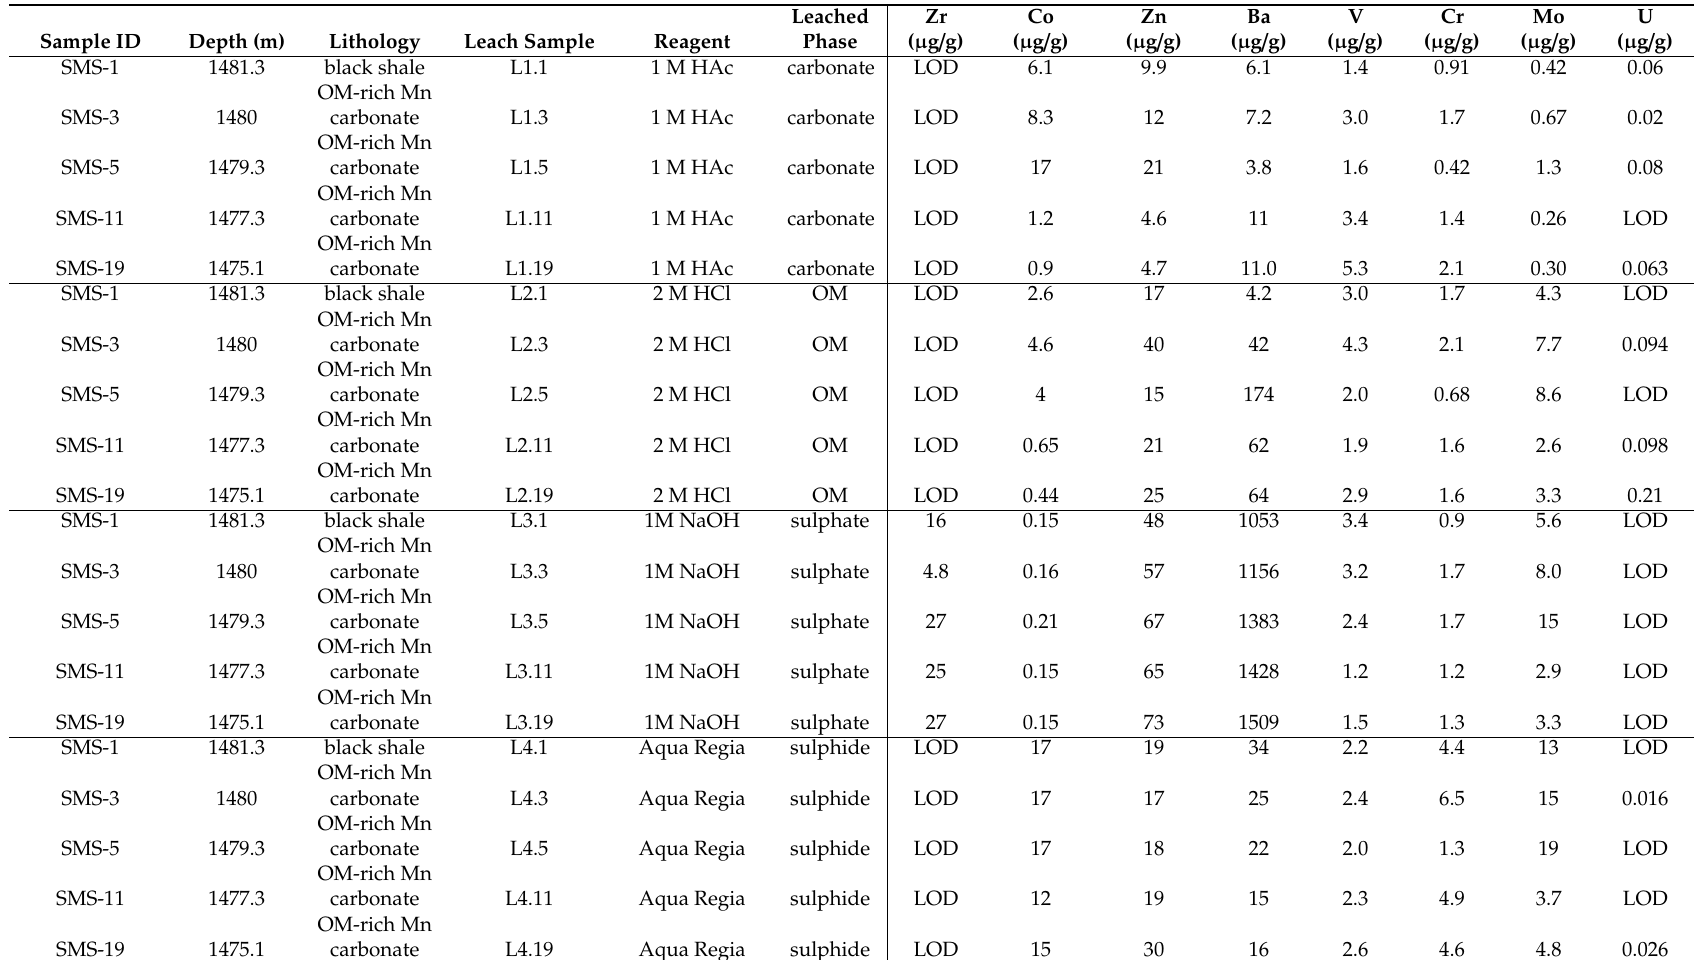
Table 1. Trace element concentrations obtained in 5 leachates and shale reference